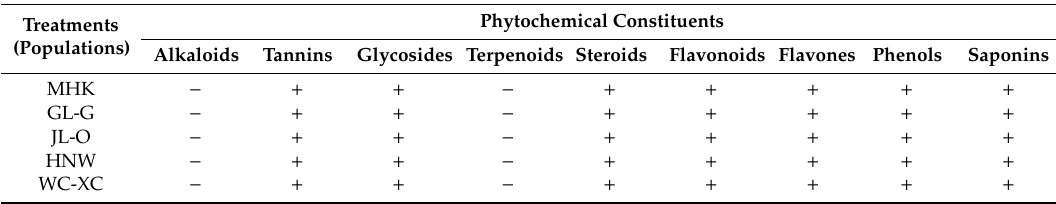
Table 1. Qualitative phytochemical screening of S. trifolia populations. Treatments (Populations)